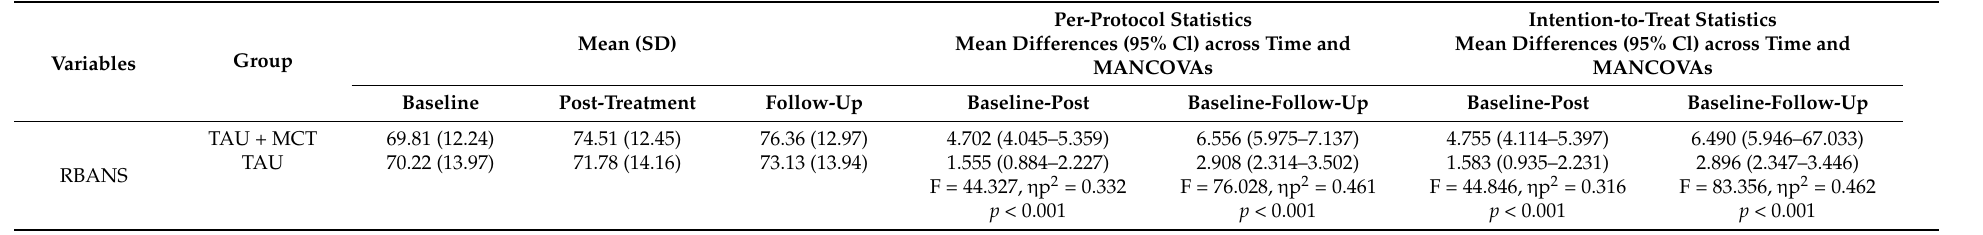
Table 2. Group differences across time on measures of cognitive function.